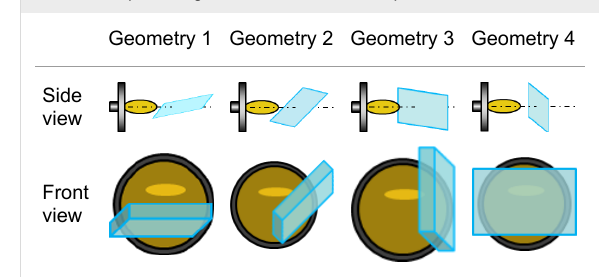
Table 1: Deposition geometries used in the